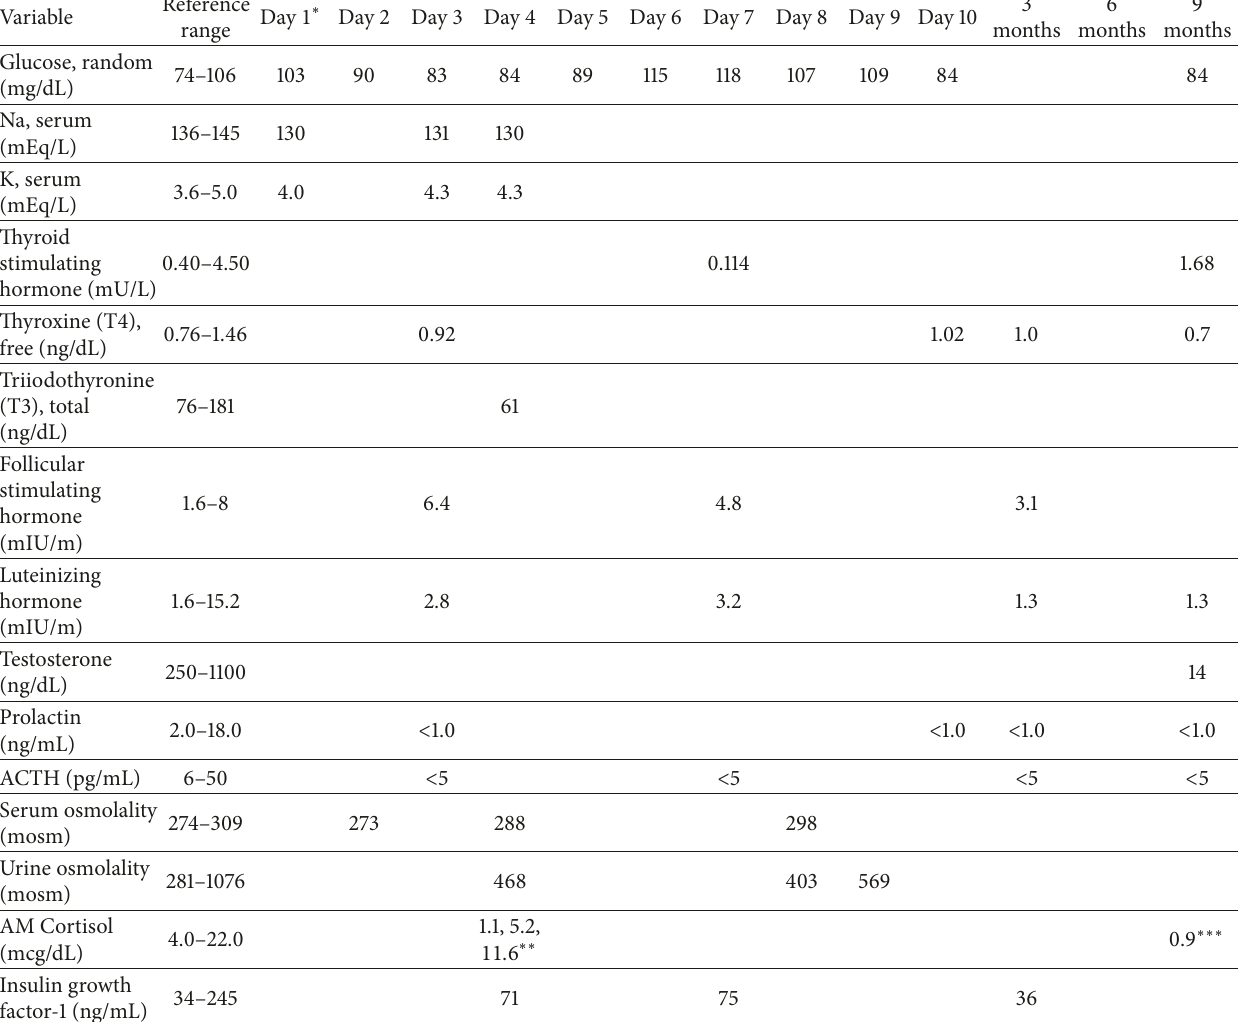
Table 1: Laboratory data